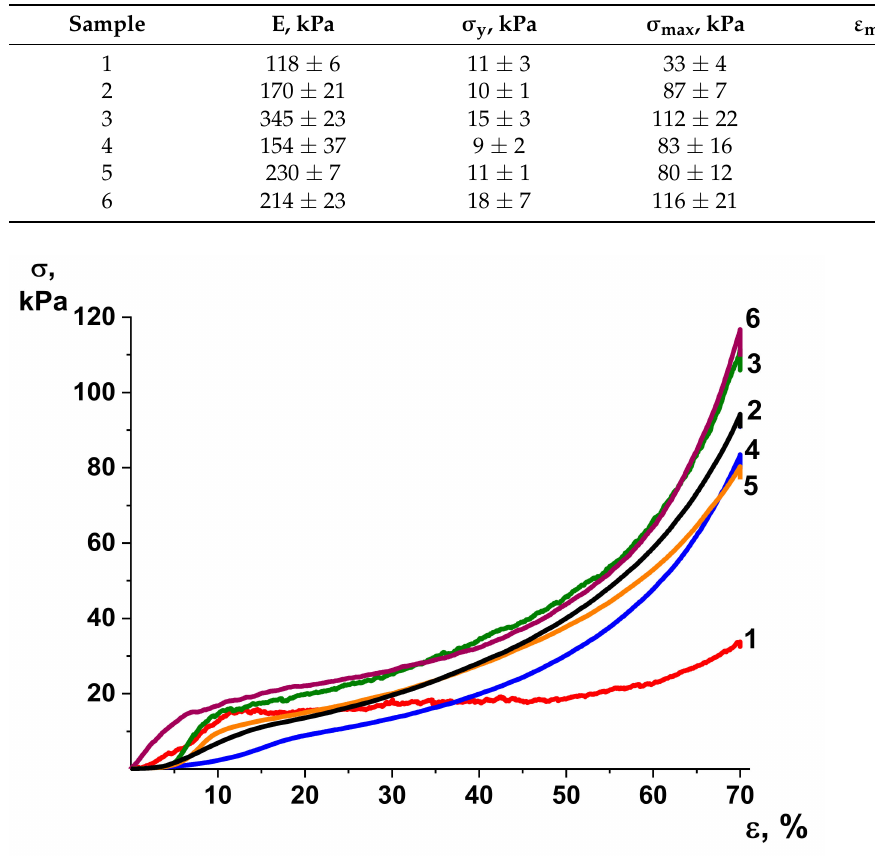
Figure 4. Stress–strain curves for chitin cryogels (Samples